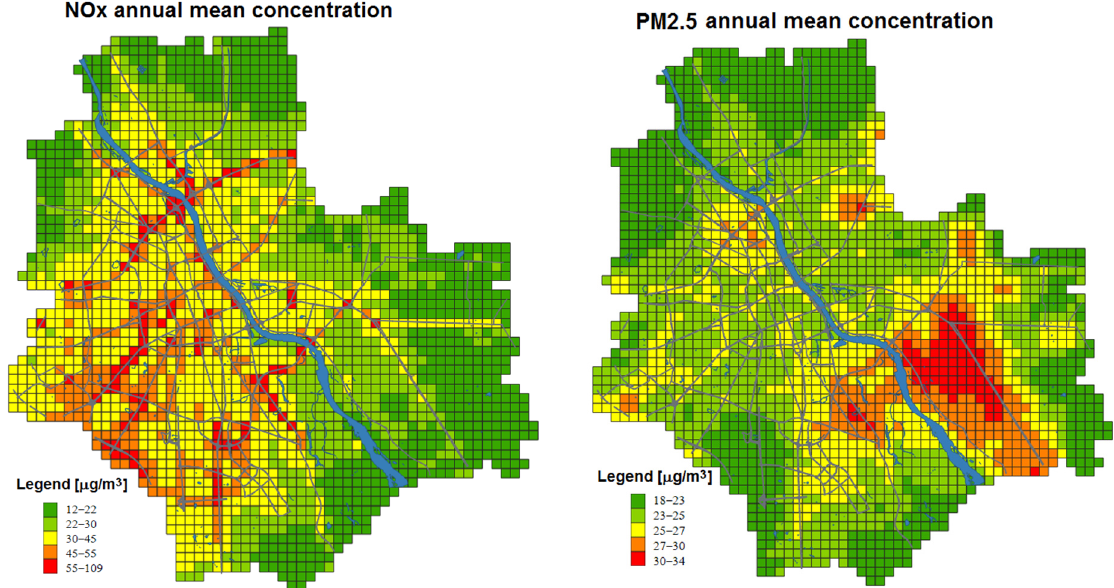
Figure 2. Concentrations for the baseline year dataset: NOx— left , PM 2.5 — right . The geographical orientation and scales are the same as in Figure 1.